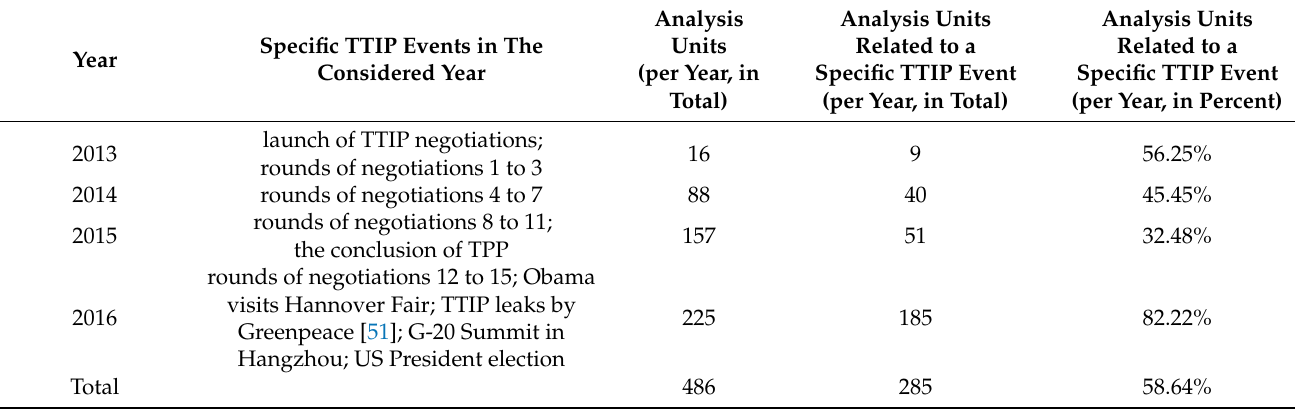
Table 2. Overview of the temporal allocation of coverage of specific Transatlantic Trade and Investment Partnership (TTIP) events per year in the print media and outline of the selected analysis units related to a specific TTIP event during the media